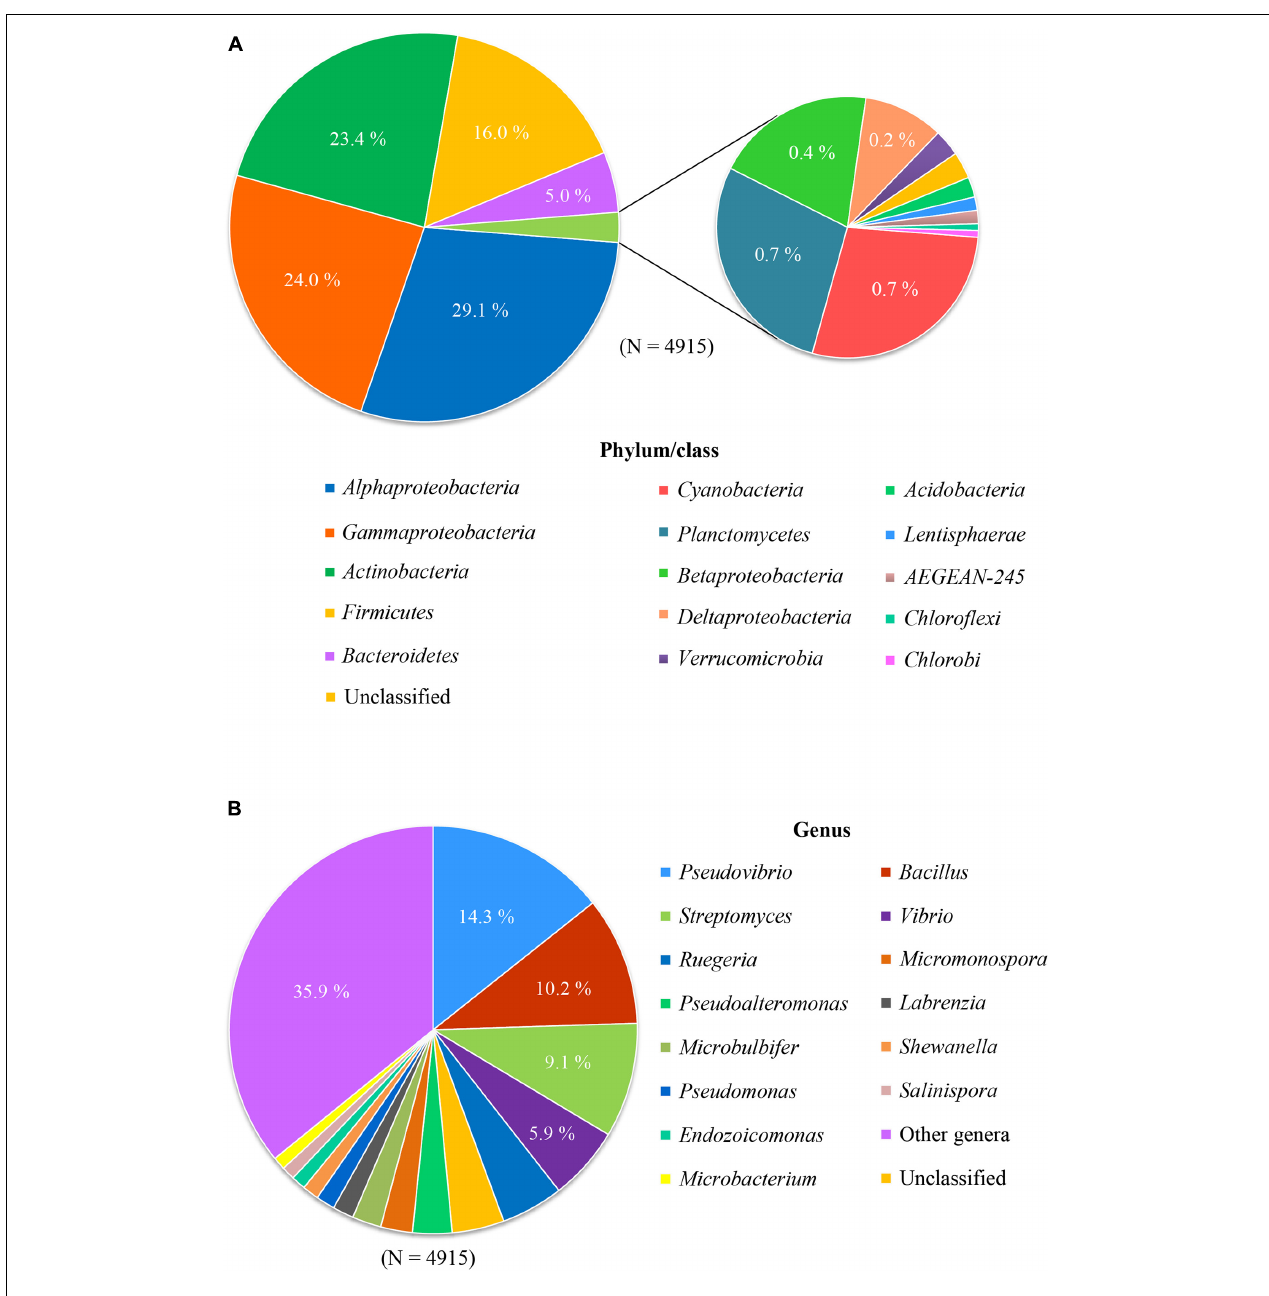
FIGURE 1 | Composition of cultured bacteria associated with sponge at phylum/class level (A) and genus level (B)